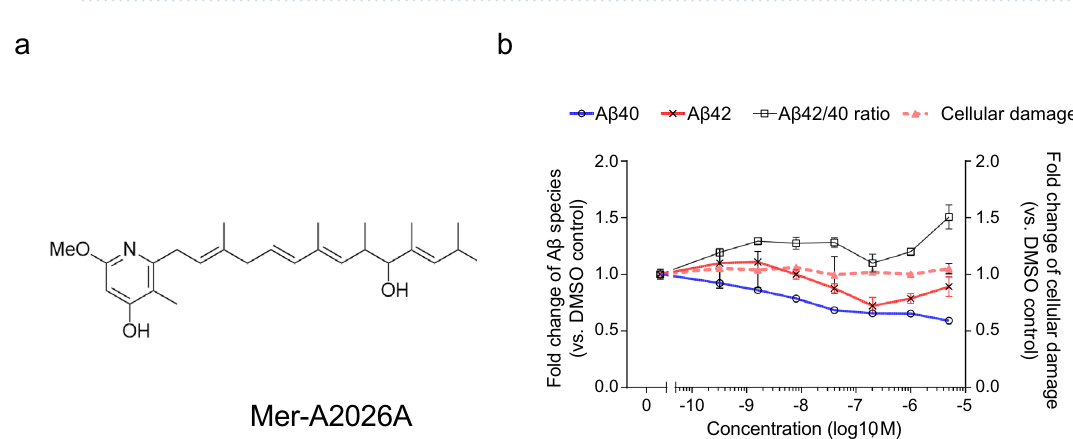
Figure 3. Verrucarin A reduced production without cellular damage. ( a ) Structure of Verrucarin A, ( b ) dose- dependent effect of Verrucarin A on Aβ40 (blue line), Aβ42 (red line), Aβ42/40 ratio (black line), and cellular damage (dash line). Data represent mean ± SD (n = 3 per clone).